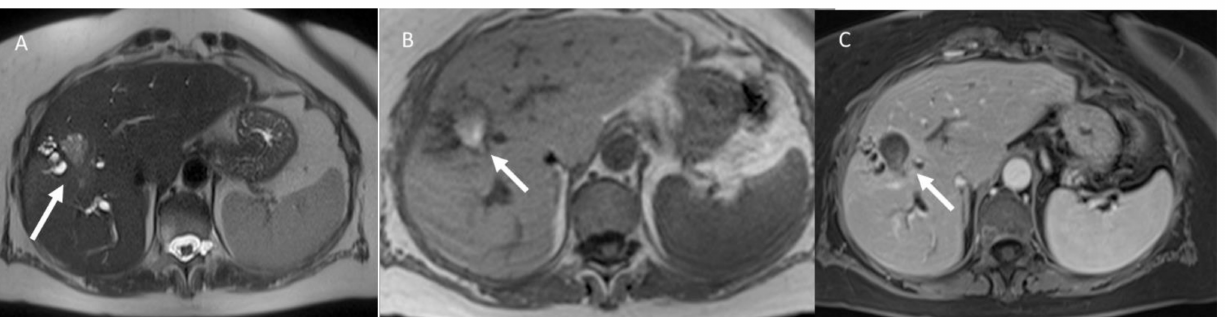
Figure 2. Woman 58 years at 1-month follow-up after microwave ablation of liver metastasis. MRI assessment ( A ) half-Fourier acquisition single-shot turbo-spin-echo (HASTE) T2-weighted sequence; in phase T1-weigthed sequence pre ( B , C ) post contrast assessment: ablated zone with biliary tree damage